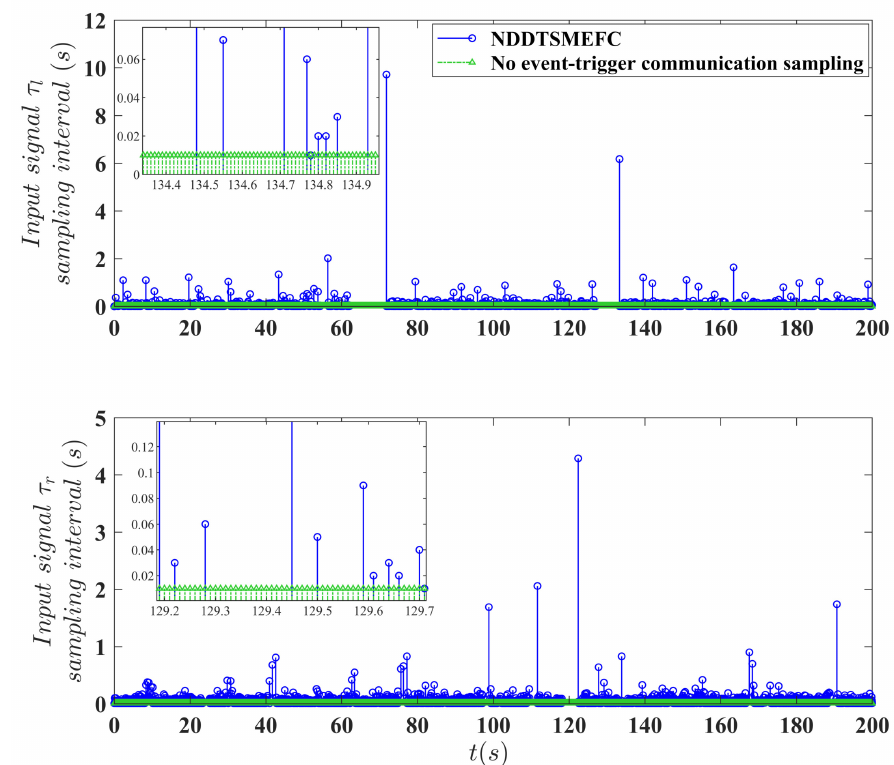
Figure 12. Schematic diagram of UROV input signal transmission sampling interval.